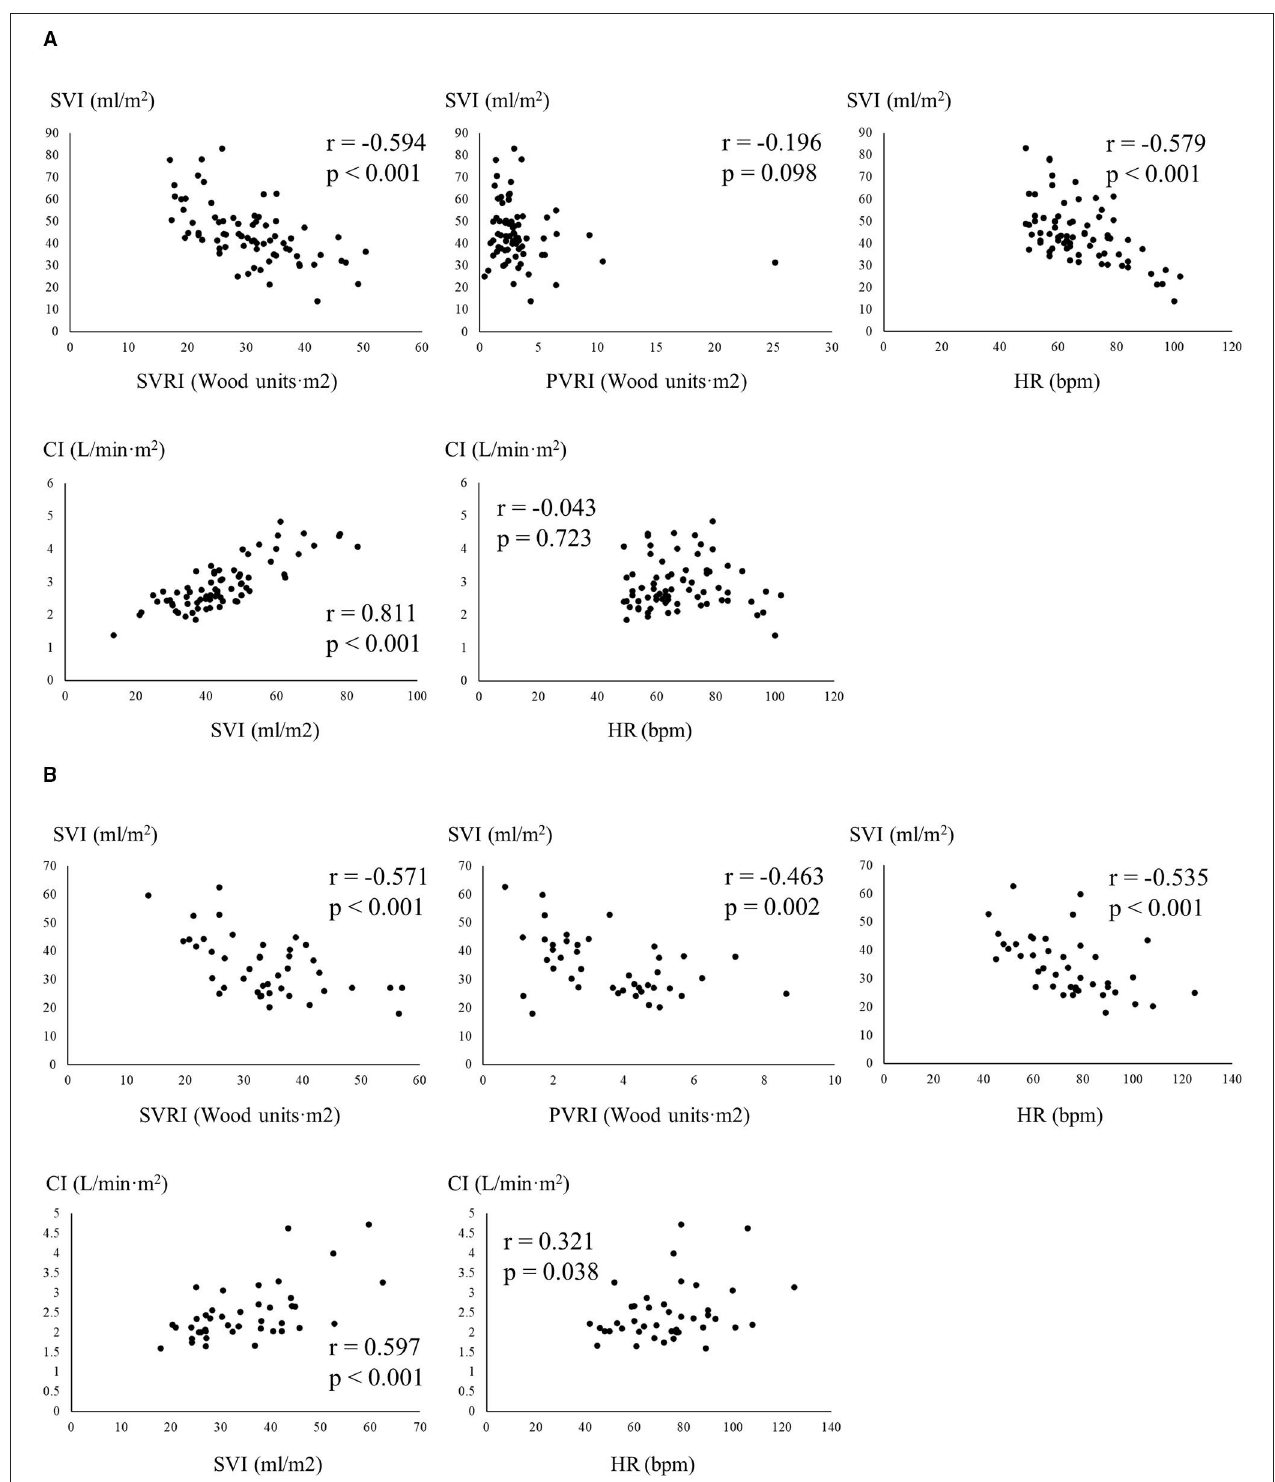
FIGURE 3 | Relationship among indices of hemodynamics measured from right heart catheterization (A) , patients with normal Y descent and preserved LV systolic ejection fraction; (B) , patients with deep Y descent and preserved LV systolic function, respectively). CI, cardiac index; HR, heart rate; SVI, stroke volume index; SVRI, systemic vascular resistance index; PVRI, pulmonary vascular resistance index.